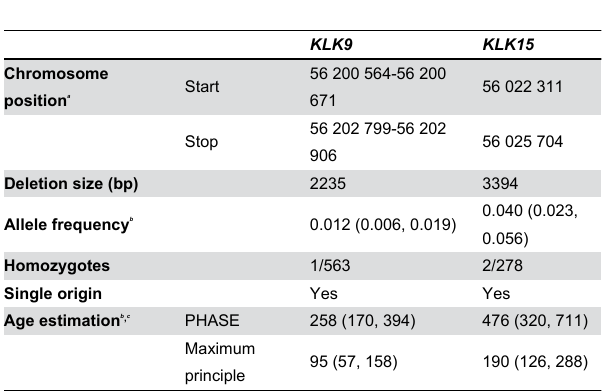
Table 3. Summary table of the deletions in KLK9 and KLK15